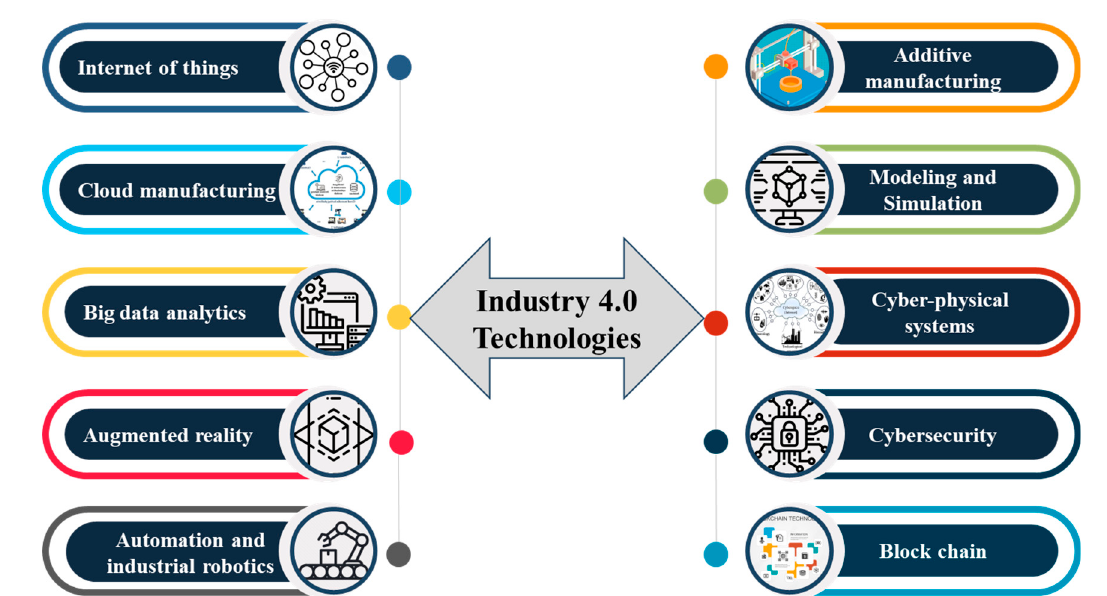
Figure 2. Industry 4.0 Technologies.